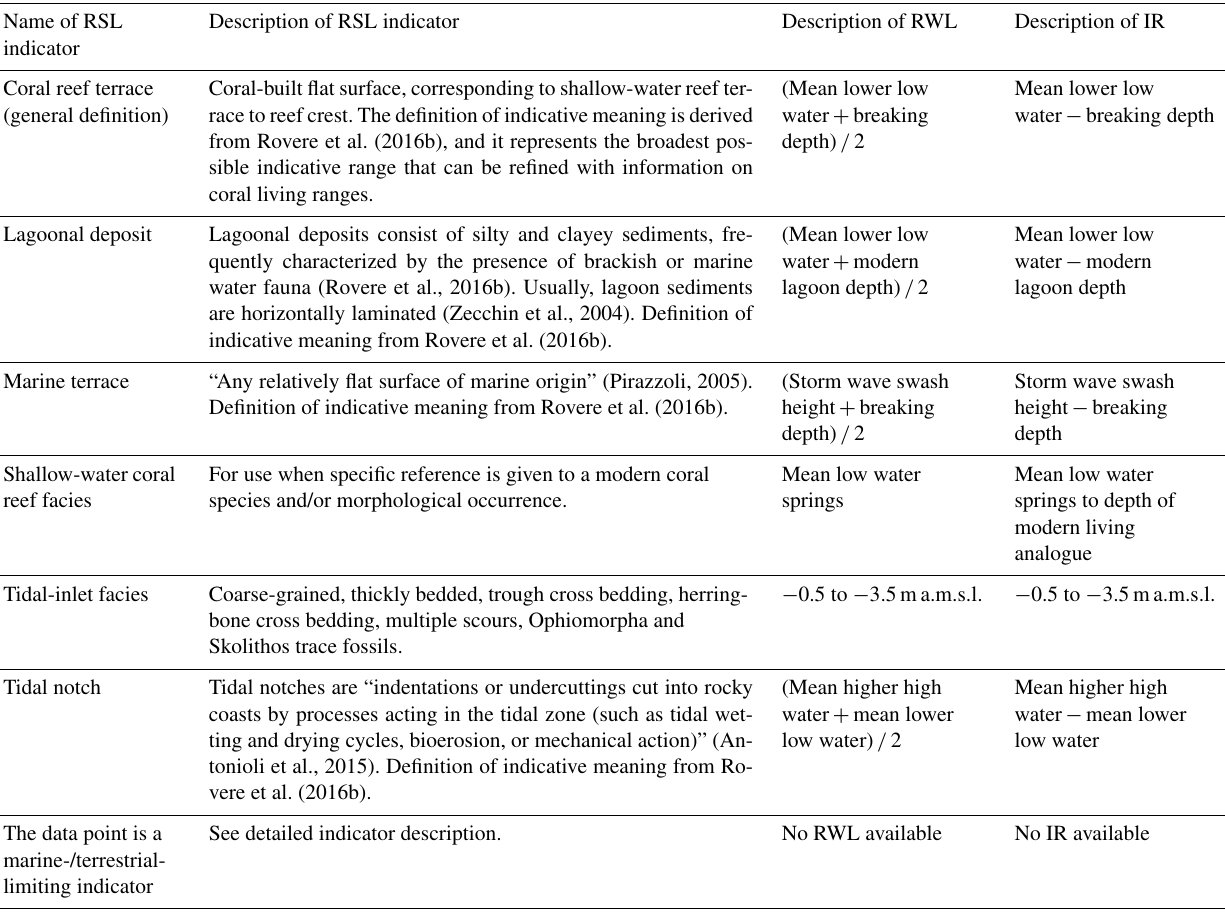
Table 1. Relative sea-level indicators and their indicative ranges. Exported from Boyden et al. (2020). Name of